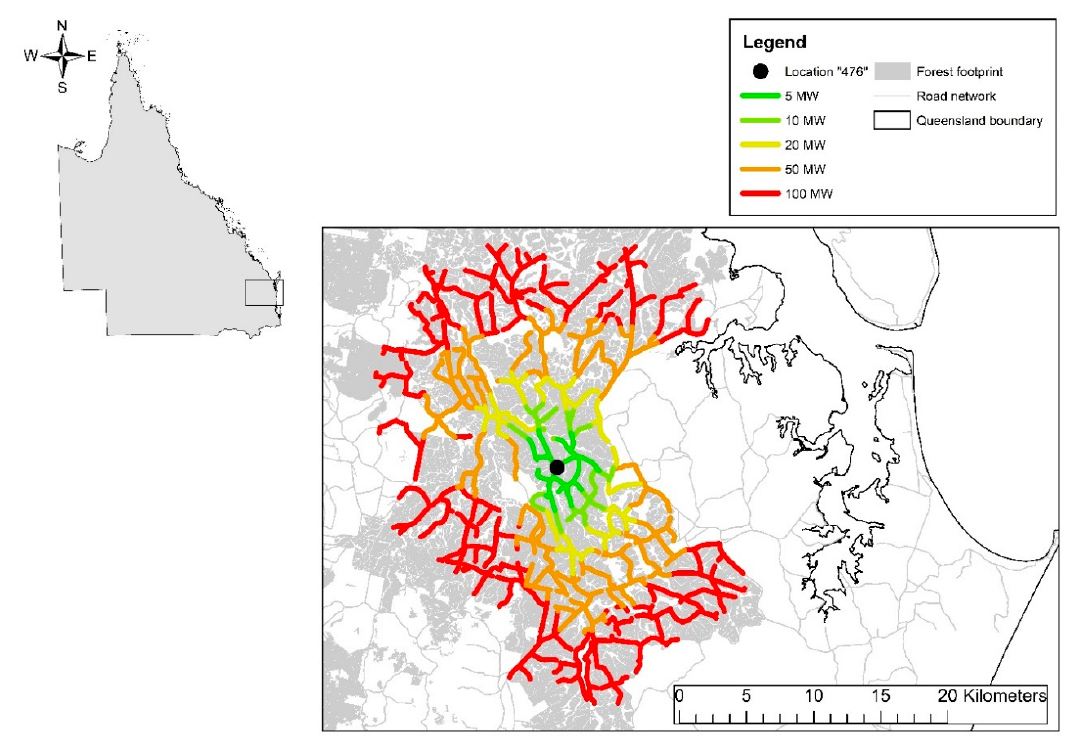
Figure 3. Location “476” and its respective connection with the forest to satisfy respective capacities of 5, 10, 20, 50 and 100 MW.